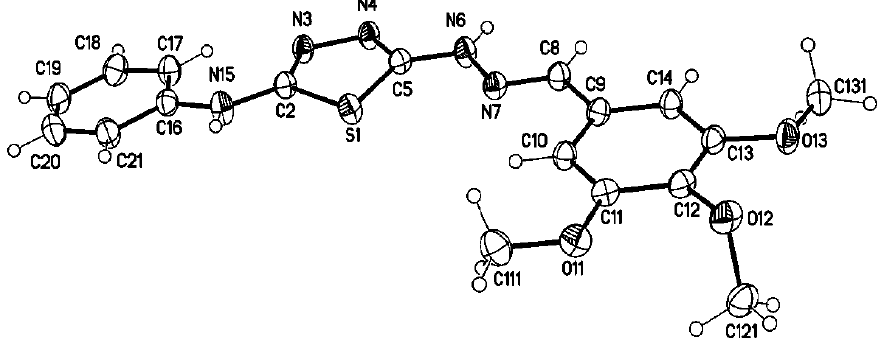
Figure 3. Molecular Structure of 2d in the crystal (one crystallographic independent molecule is shown, displacement parameters are drawn at 30% probability level).